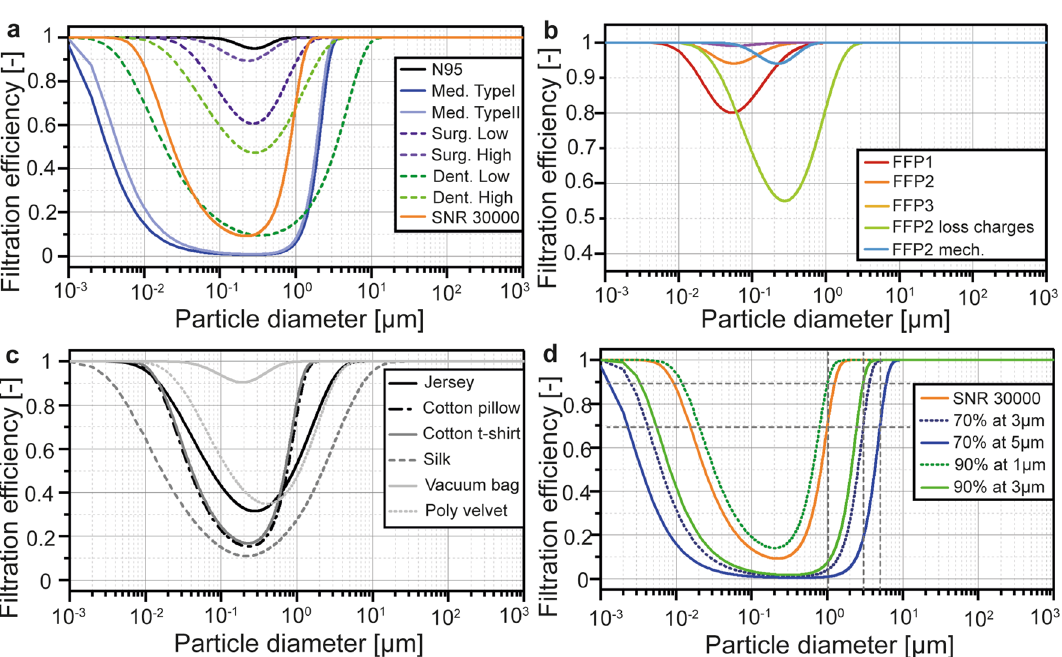
Figure 3. Filtration efficiency curves of the facemasks modelled and investigated in the present work, divided into three categories. Certified masks ( a , b ) were based on the standards EN 149 and SNR 30000 as well as on data from the literature. The different FFP-certified protections were modelled ( b ) together with additional FFP2 masks to investigate the influence of a loss of electrostatic charges and the worst-case scenario permitted by EN 149 through a FFP2 mask based on mechanical filtration. Homemade masks ( c ) were based on filtration data from the literature. Virtual masks ( d ) followed a prescribed efficiency at a defined particle size. The SNR 30000 standard is added in ( d ) for comparison